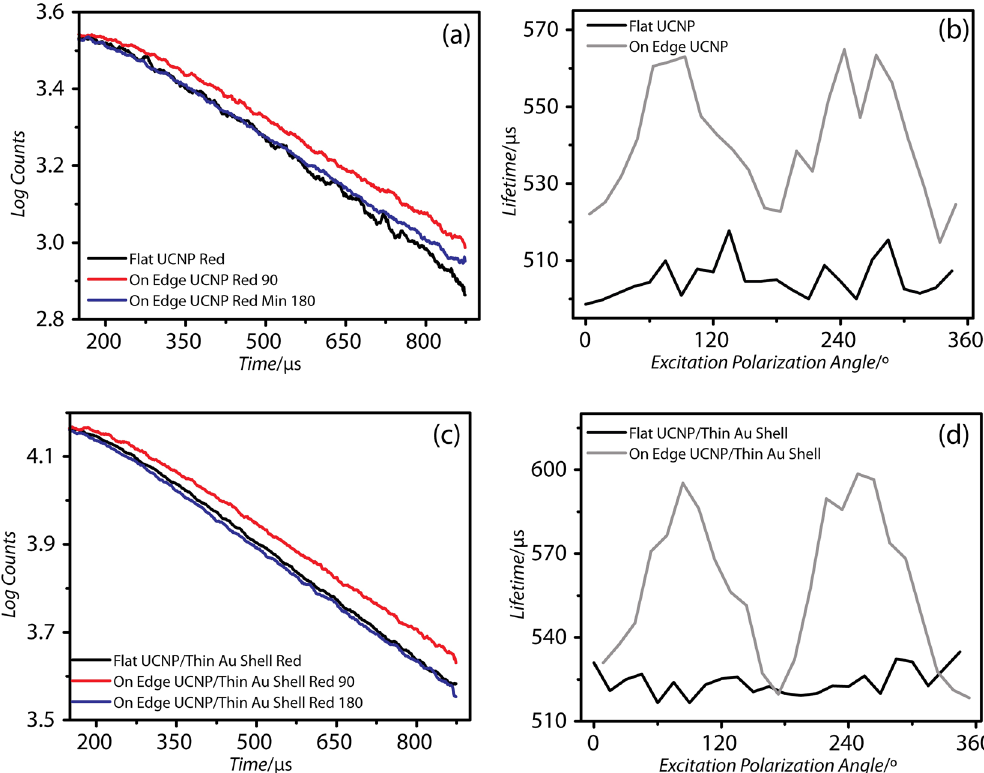
Figure 5. Time-resolved decay of ( a ) unmodified UCNP and with ( c ) 18 nm gold shell coating (NP-UCNP) with corresponding dependence of the radiative lifetime on the excitation polarization angle for the Er 3 + ; 4 F 9/2 to 4 I 15/2 transition for unmodified ( b ) and NP-UCNP ( d ). The spectral measurement standard deviation is less than 0.001.